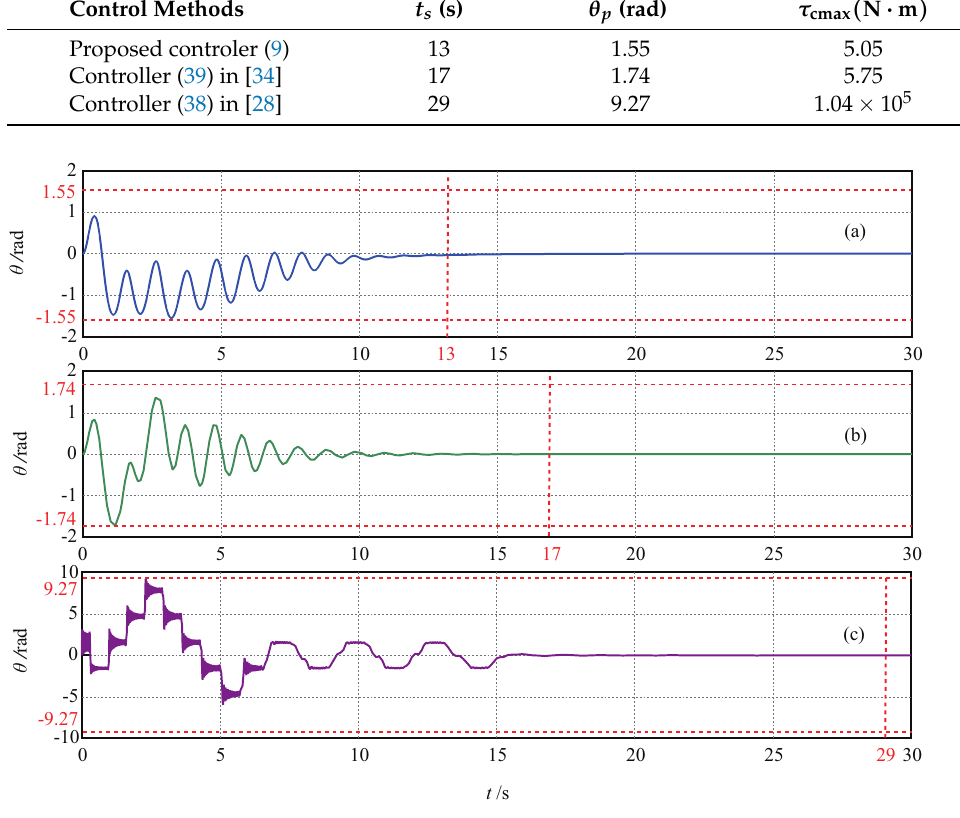
Figure 3. Time response curves of the ball rotational angle θ . ( a ) Proposed method; ( b ) Method in [34]; ( c ) Method in